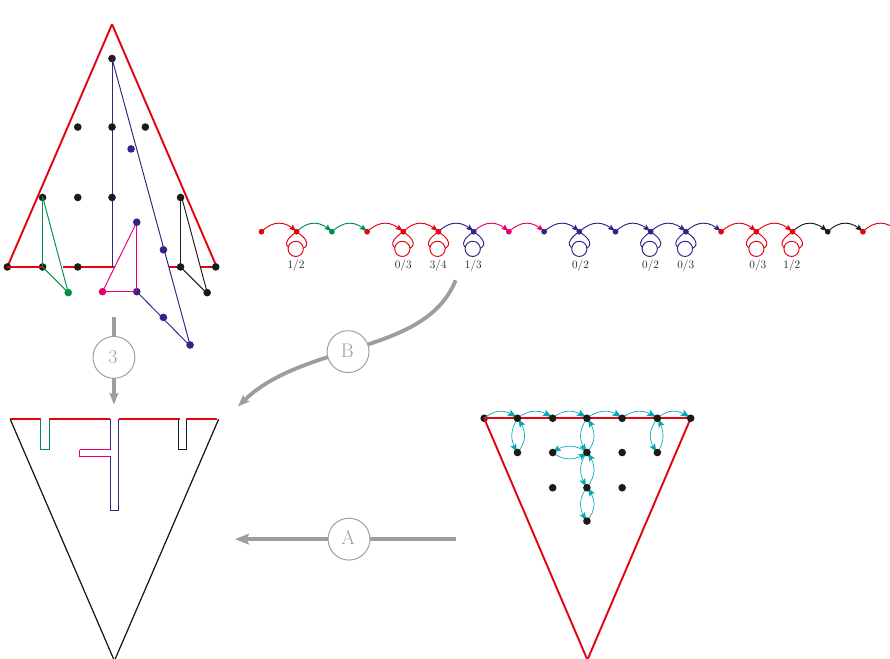
Figure 2. The Discrete QCD parton shower algorithm can be re-interpreted as a one-dimensional random walk, since 3 the baseline of the folded structure carries all necessary information. The “grove-like” baseline structure can A be generated by a heavily constrained two-dimensional random walk. Due to the low fractal dimension of the grove structure, a one-dimensional random-walk algorithm B is equally viable. For B , the notation n/n max indicates that option n was picked out of n max choices. The two-particle invariants ( ln( s ij ) ) can be read off by following the path from particle i to particle j , and skipping segments whose colour was created and reabsorbed along the way (e.g. skipping the pink segments when calculating the invariant mass of the green and blue gluon